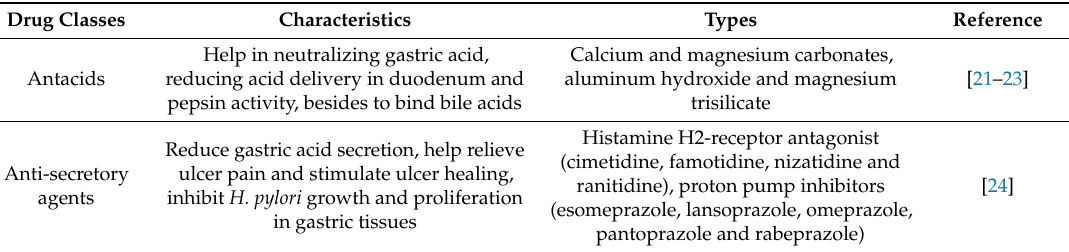
Table 1. Main drug classes used in peptic ulcer